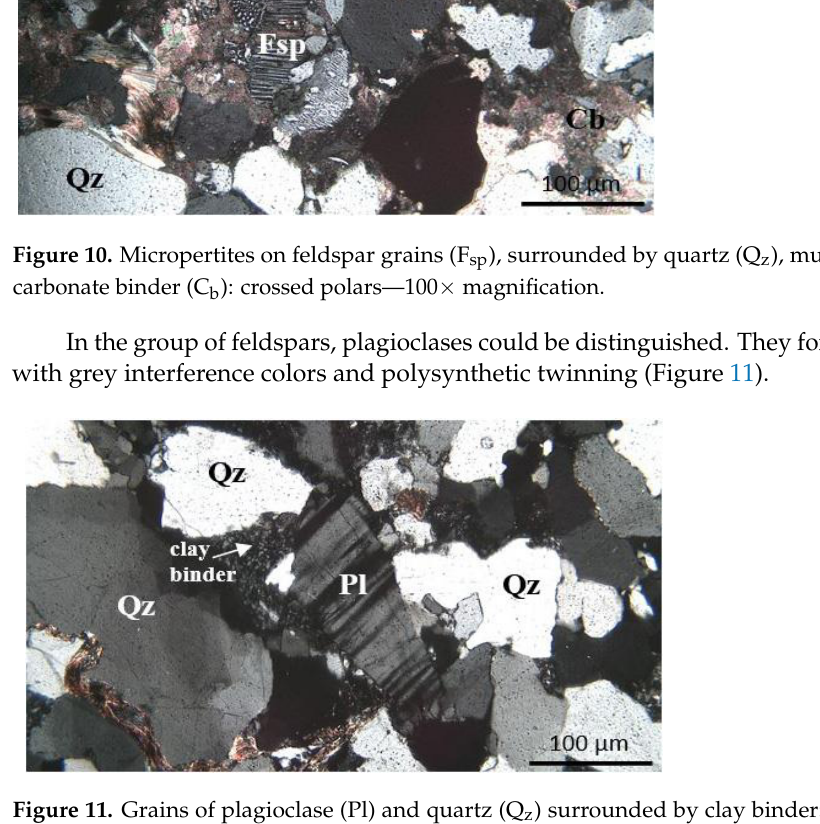
Figure 12. Zirconium (Zrn): crossed polars—100× magnification.